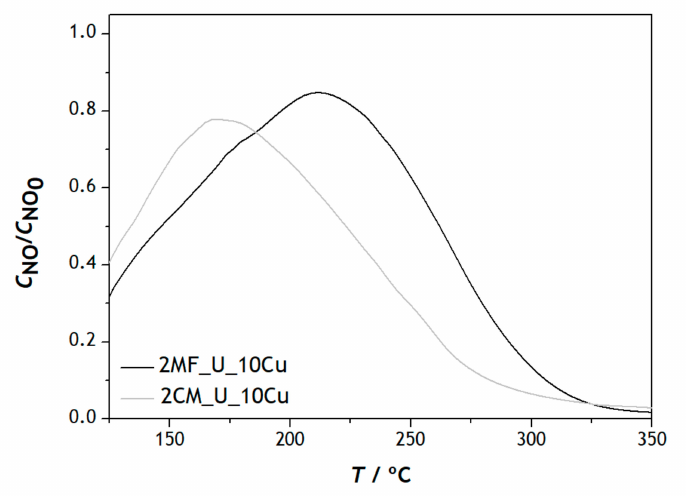
Figure 8. NO concentration in the presence of MF and CM with [NO] = 1000 ppm in He with 5% of O 2